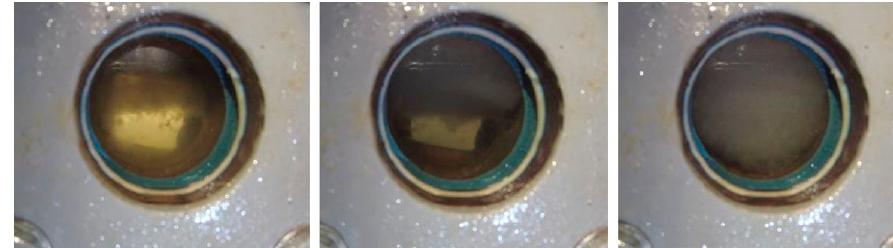
Figure 7. Hydrate formation record, scale 1:2.